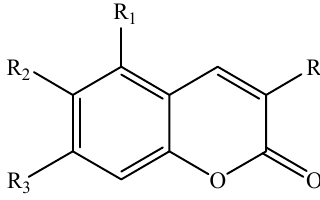
Figure 3. Structure of the coumarins identified in Haplophyllum species—part 1.